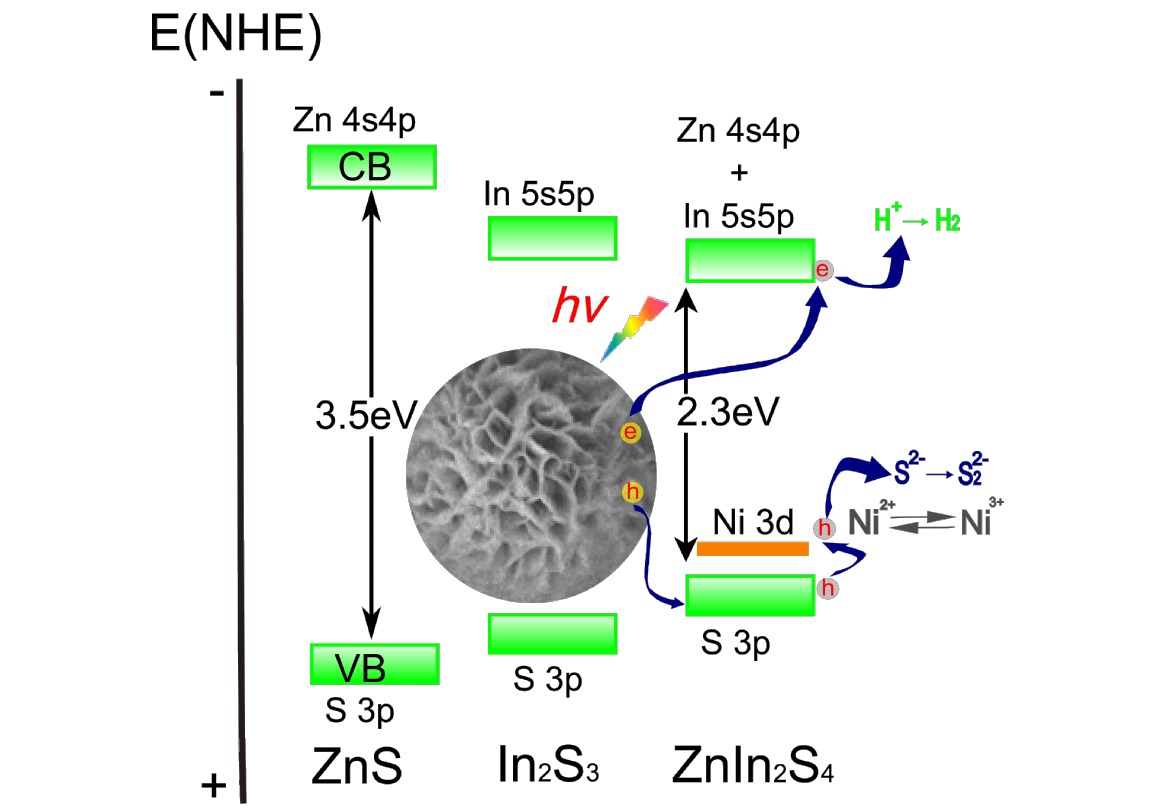
Figure 9: Photocatalytic mechanism over Ni-doped ZnIn 2 S 4 with plenty of curved nanosheets. Reprinted with permission from [61]. Copyright (2010), Springer.